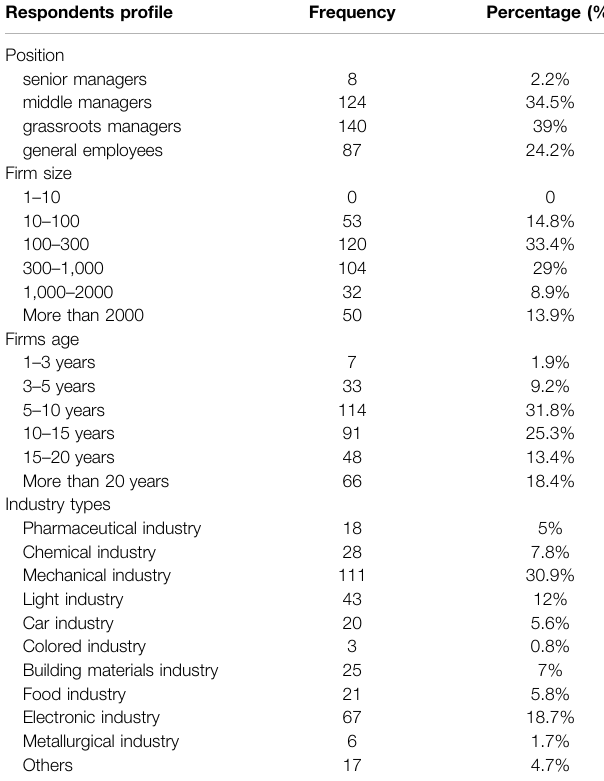
TABLE 1 | Background of respondents and fi